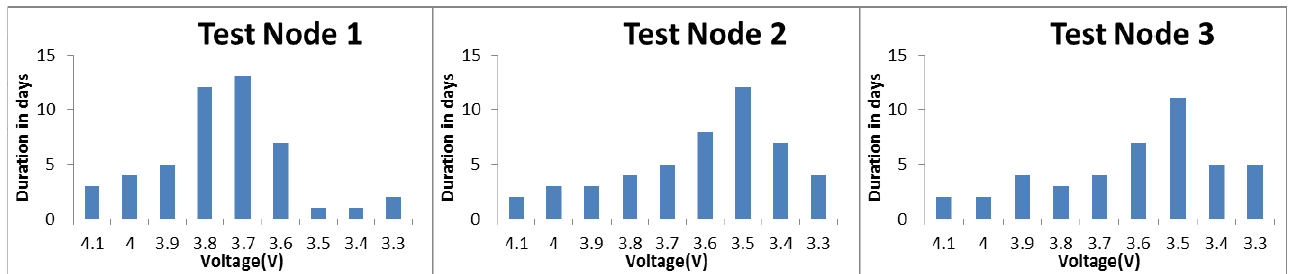
Figure 7. A relational graph of the voltage level and continuous operation